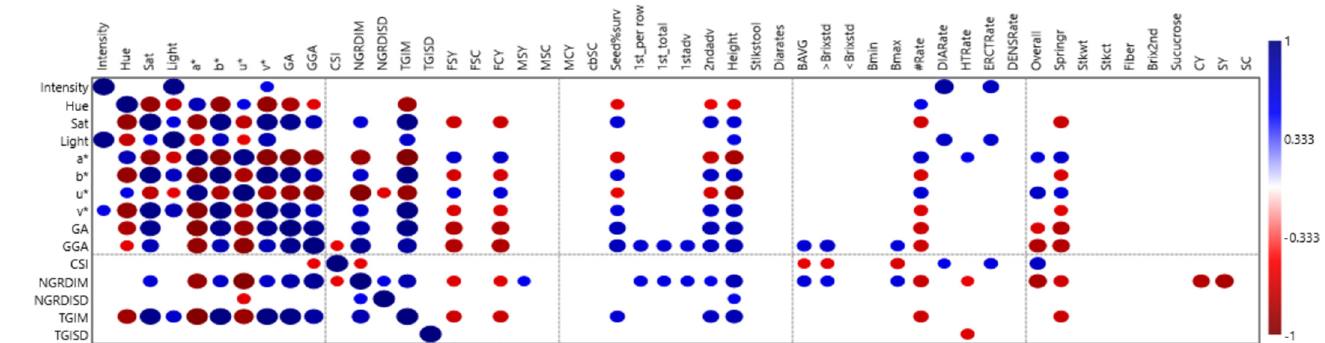
Figure 2. Corrogram of first ratoon spectral traits taken on 28 June 2019 with breeding and yield traits. Only significant correlations are shown and the larger the circle the larger the correlation with color scale describing the correlation. Height, Stalk height (cm); stlkstool, stalks per stool; Diarates, Stalk diameter rating per stool; BAVG, Brix average from field brixing of 20 seedling stools; >Brixstd, Those selected greater than or equal to Brix standard in seedling trials; <Brixstd, Those not selected based on field Brixing less than field standard in seedling trials; Bmin, Minimum Brix of a family in seedling trials; Bmax, Maximum Brix of a family in seedling trials; #Rate, Seedling stalk number rating: 1 best and 9 worst; DIARate, Seedling diameter Rating: 1 best and 9 worst; HTRate, Seedling height Rating: 1 best and 9 worst; ERCTRate, Seedling erectness rating: 1 best and 9 worst; DENSRate, Seedling density rating: 1 best and 9 worst; Overall, Seedling overall Rating: 1 best and 9 worst; Springr, Seedling spring ratings; FSY, sugar per acre yield of female parent; FSC, sugar per ton yield of female parent; FCY, tons cane per acre yield of female parent; MSY, sugar per acre yield of male parent; MSC, sugar per ton yield of male parent; MCY, tons cane per acre yield of male parent; cbSC, Combined average of sugar per ton yield of both parents; Seed%surv, Seedling survival counts; 1st_per row, First line selections per row; 1st_total, Total first lines selected; 1stadv, Ratio of first lines selected from seedling stage; 2ndadv, Ratio of second lines selected from first line stage; Intensity, CIELab color component; Hue, hue angles in the a*b* plane of the CIELab color space and vary from 0 to 360 ◦ where 0 ◦ is red, 60 ◦ is yellow, 120 ◦ is green, and 180 ◦ is cyan; Sat, Saturation: defines the color purity from white to the corresponding primary color; Light, Lightness: represents the range from black to white with pure black having a value of zero and pure white having a value of ten; a*, The range from green to red; b*, The range from blue to yellow; u*, The scale from blue to red; v*, The scale from blue to green; GA, included the green area (GA), which is the proportion of green pixels in an image; GGA, The greener area (GGA) excludes yellow pixels that correlate with senescent leaves; CSI, the Crop Senescence Index (CSI) = (GA − GGA)/GA × 100; NGRDIM, Mean of the image the Normalized Green–Red Difference Index (Rg − Rr)/(Rg + Rr); NGRDISD, Standard Deviation of NGRDI; TGIM, Mean of the image Triangular Greenness Index − 0.5[( λ r − λ b)(Rr − Rg) − ( λ r − λ g)(Rr − Rb)]; TGISD, Standard Deviation of the TGI; Slkwt, Stalk weight of second line trials; Stkct, Stalk count of second line plots; Fiber, % fiber calculated from 10 stalk sample in second lines; Brix2nd, Second Line Brix; Sucrose, % Juice sucrose content; CY, Cane yield Mg ha − 1 ; SY, Sugar yield Mg ha − 1 ; SC, g kg − 1 Theoretical recoverable